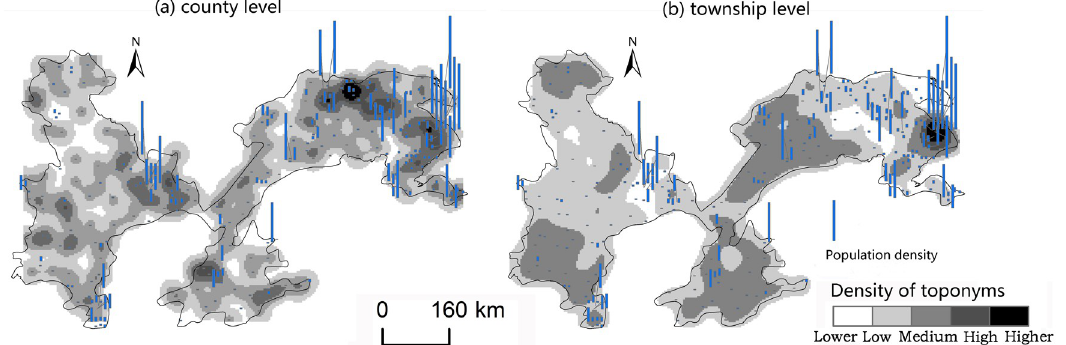
Fig 14. Spatial distribution of toponym density and county population density in the Yangtze Plain.